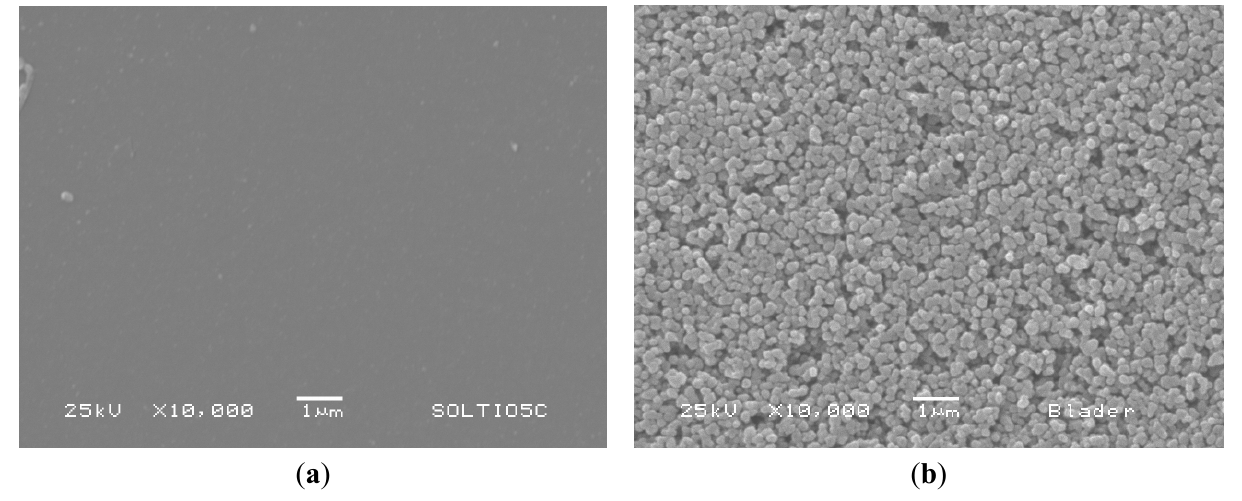
compact layer overlying conductive glass plates and 2 layer produced by screen-printing technique. 2